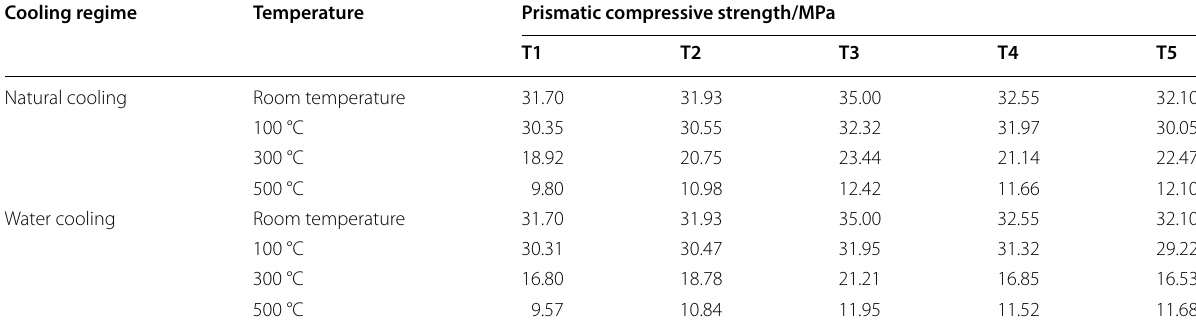
Table 4 Prismatic compressive strength of concrete produced with desert sand after elevated temperature.